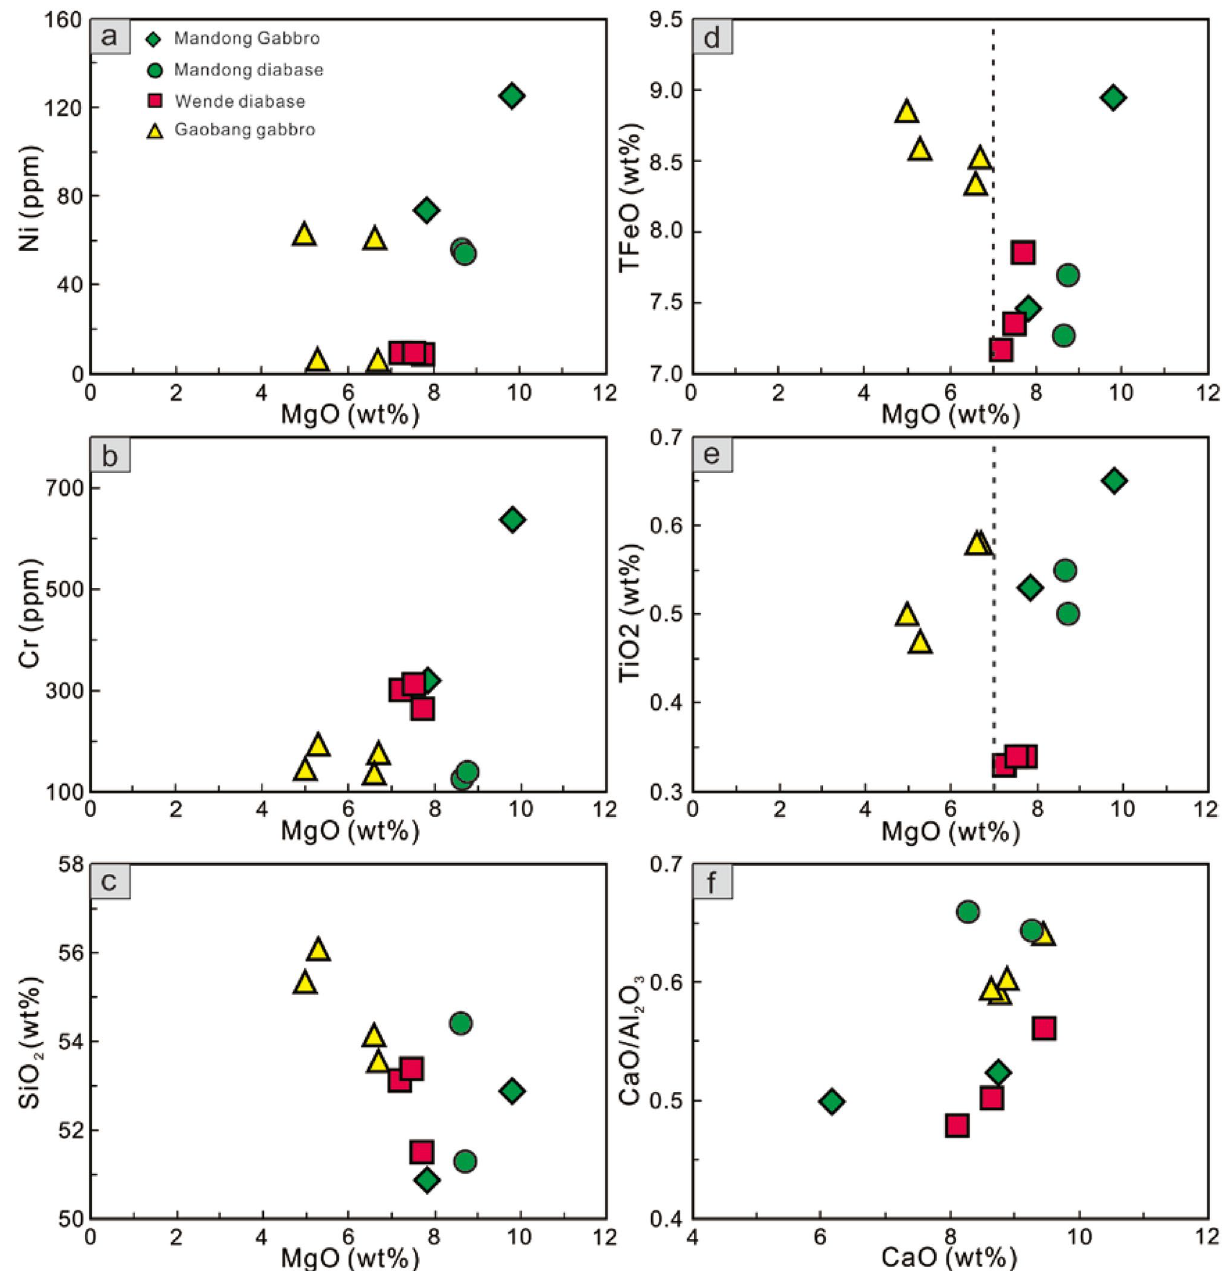
Figure 8. Variation diagrams of Ni, Cr, SiO 2 , TFeO and TiO 2 versus MgO ( a – e ), and CaO/Al 2 O 3 versus CaO ( f